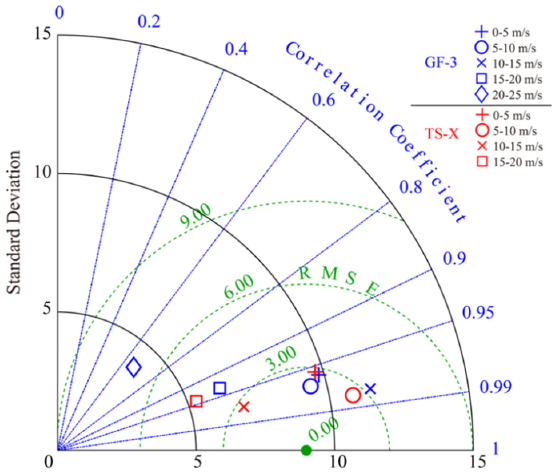
Figure 11. Comparison of composited NRCS with SAR-measured NRCS for wind speeds of 0 to 25 m/s. The blue and red marks illustrate the results for GF-3 and TS-X, respectively. The ratio of the NP component σ wb on the σ VV and NRCS σ HH was calculated for 0 0 investigating the performance of the NP contribution to the dual-polarized C-band and X-band SAR. Figure 12 shows the relationships between the ratio ( σ wb / σ VV and σ wb / σ HH ) 0 0 and the SAR-derived wind speed, SAR-derived SWH, and HYCOM current speed. The red and black lines illustrate the results for the GF-3 and TS-X images, respectively. In general, the ratios for the GF-3 are higher than those of the TS-X. The wavelength (~5 cm) at